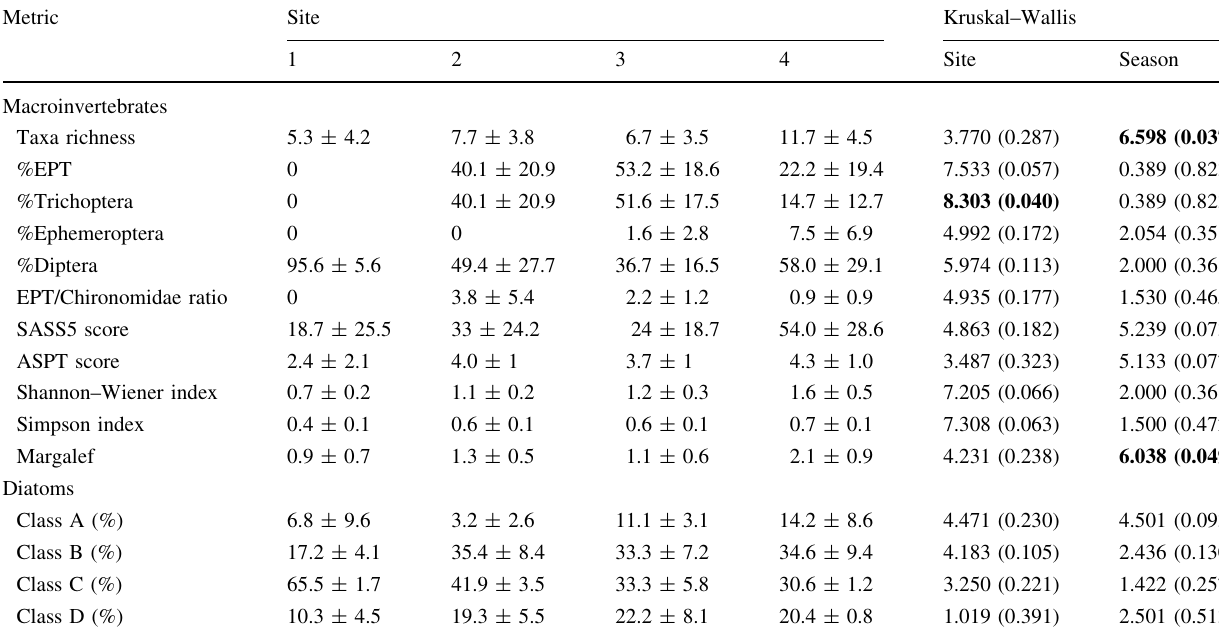
Table 2 Macroinvertebrates and diatom community metrics (mean ± standard deviation) for the four study sites recorded on the Ngamo River